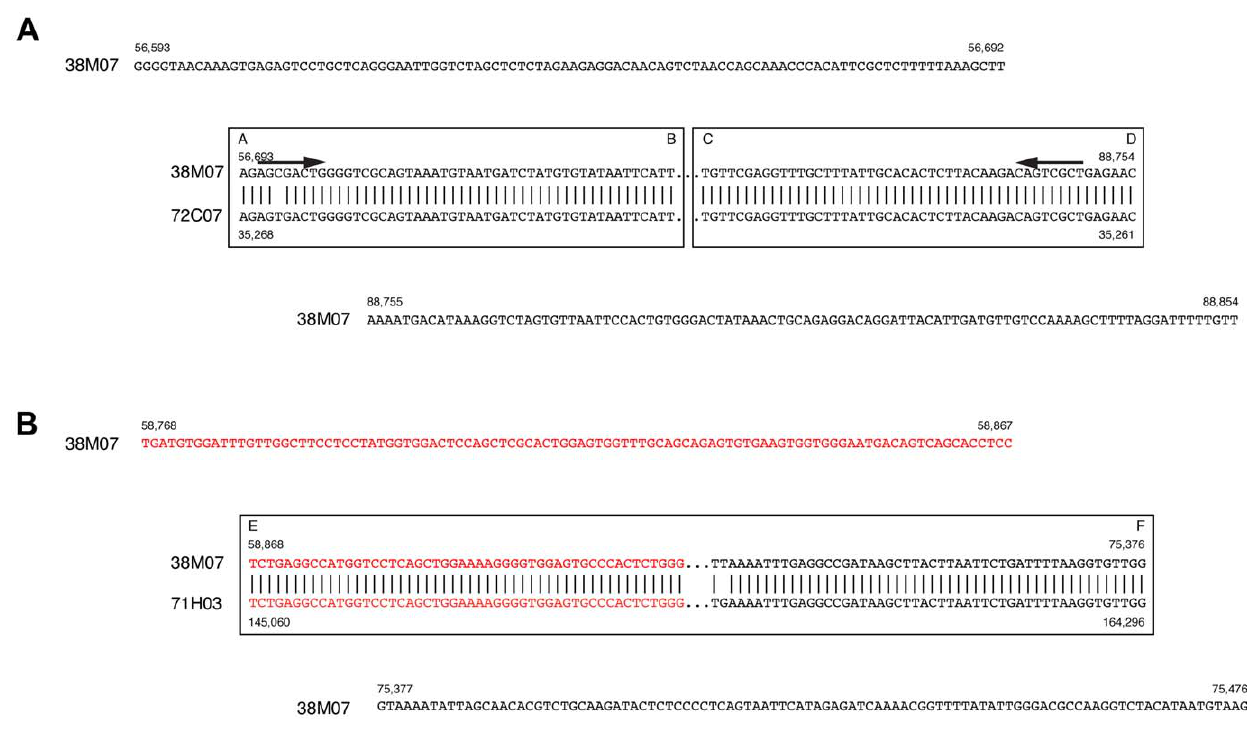
Figure 8. Sequences of the duplication boundaries. (A) 100 bp of 38M07 sequences flanking the left side of Box A–B and the right side of Box C–D. Black arrows indicate an 8 bp inverted repeat at sites A and D. (B) 100 bp of 38M07 sequences flanking Box E–F. Red letters indicate an Expander LINE, shown in Figure S5. Boxes A–B, C–D, and E–F correspond to those of Figures 5, 7, S3, S4 and S5.